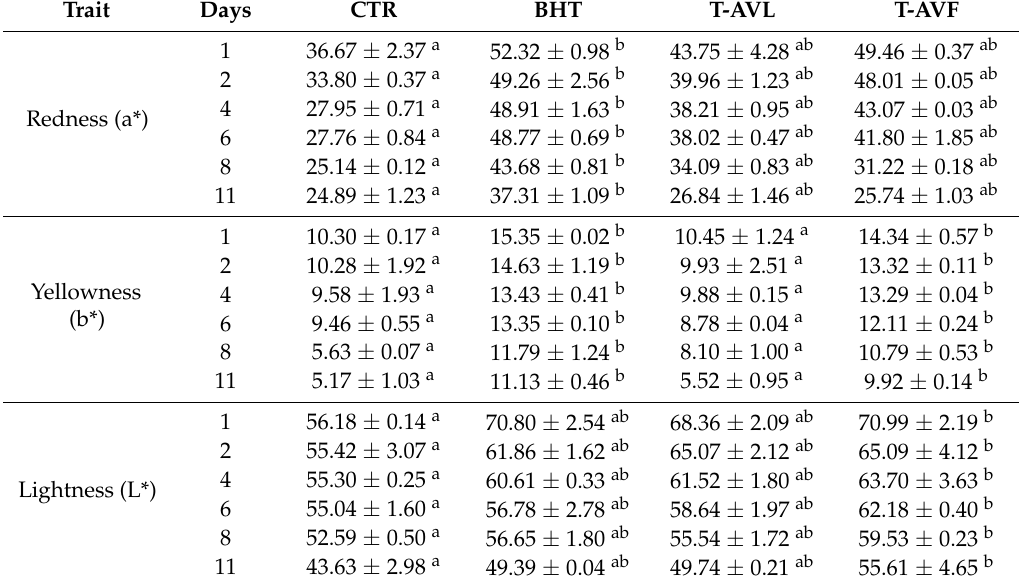
Table 4. Color characteristics of raw beef patties formulated with powdered leaves and flowers of A. vulneraria during storage at 4 ± 1 ◦ C CTR (Control sample without antioxidant), BHT (treatment with synthetic antioxidant (Butylated hydroxytoluene)), T-AVL (treatment with A. vulneraria leaf), T-AVF (treatment with 0.5% A. vulneraria flower). Trait Days CTR BHT T-AVL T-AVF